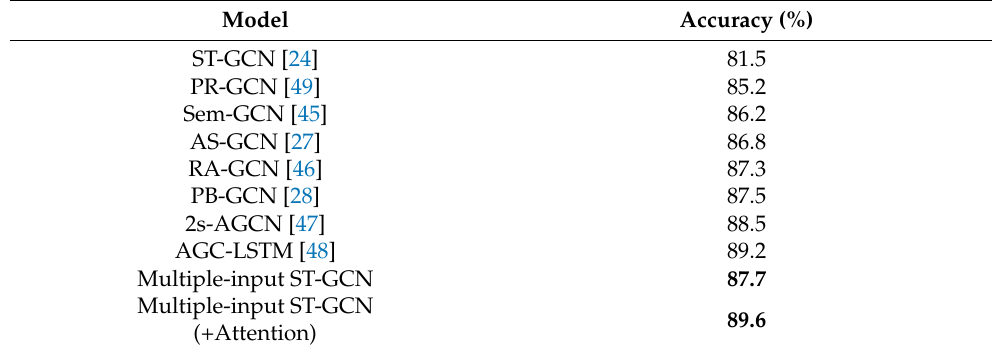
Table 3. Comparison of performance of the proposed method with the schemes in the literature for NTU RGB+D